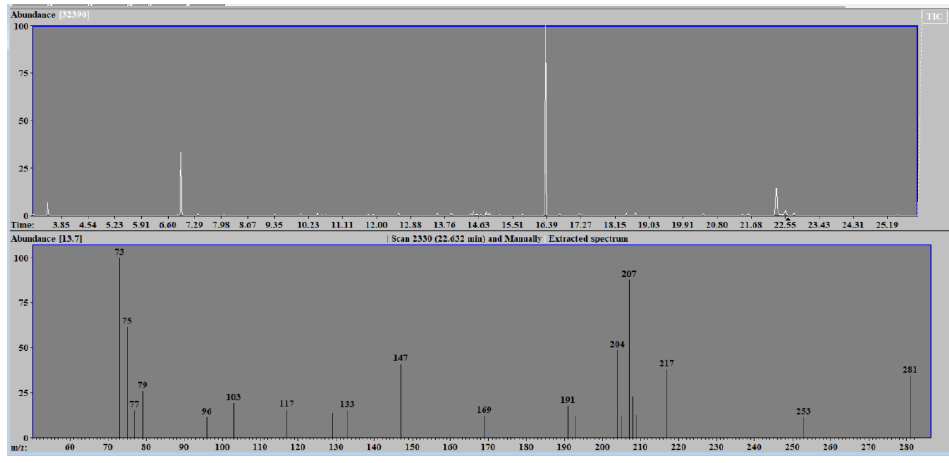
Figure 1. Example of mass spectrometry spectrum.